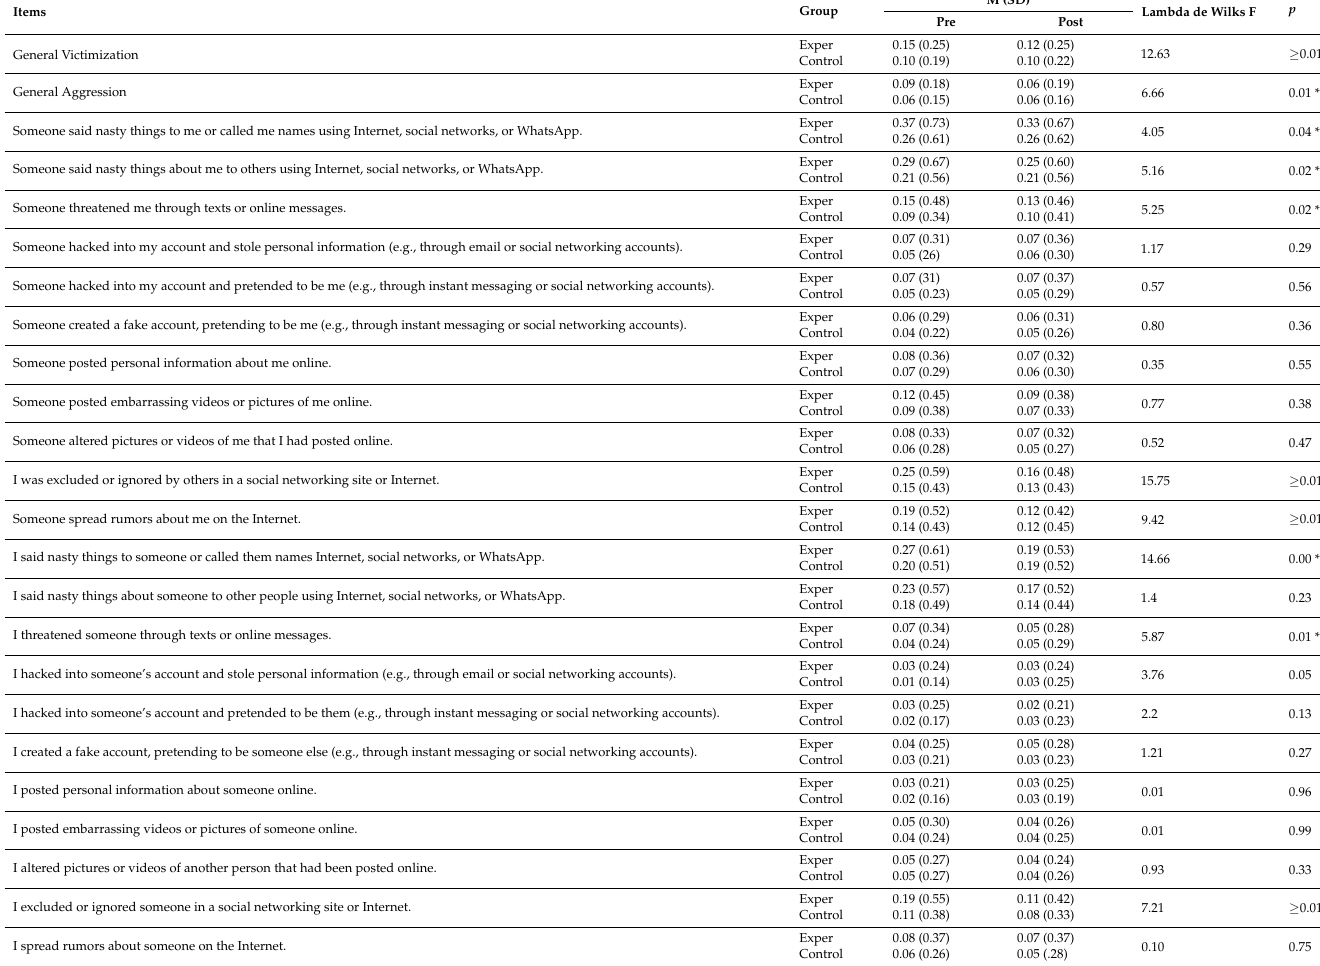
Table 3. Multivariate analysis of variance (MANOVA)